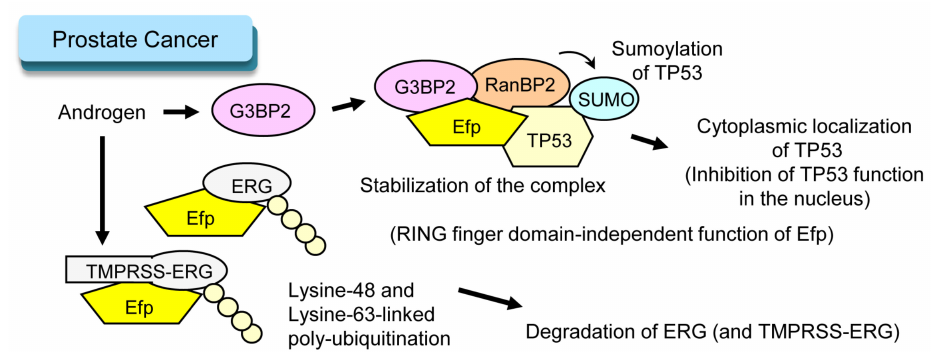
Figure 2. Roles of Efp in prostate cancer. Efp is involved in function of an androgen-dependent protein, G3BP2. This mechanism is independent of E3 ubiquitin ligase activity of Efp. Efp was also reported to be involved in degradation of a fusion protein encoded by TMPRSS2-ERG fusion gene, which seems to be tumor suppressive. Note that transcription of TMPRSS2/ERG is induced by